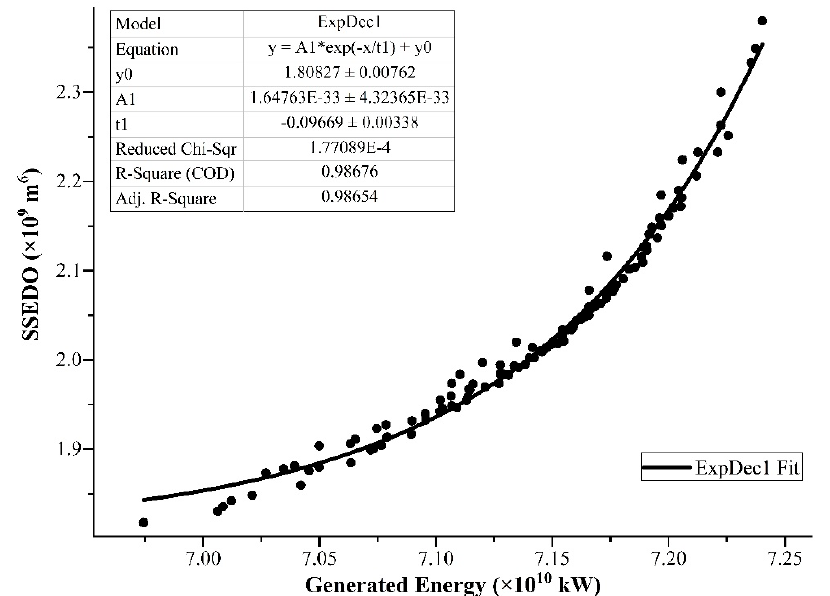
Figure 7. The non-dimensional analysis of the square sum of the ecological water deficit and overflow (SSEDO) and generated energy.